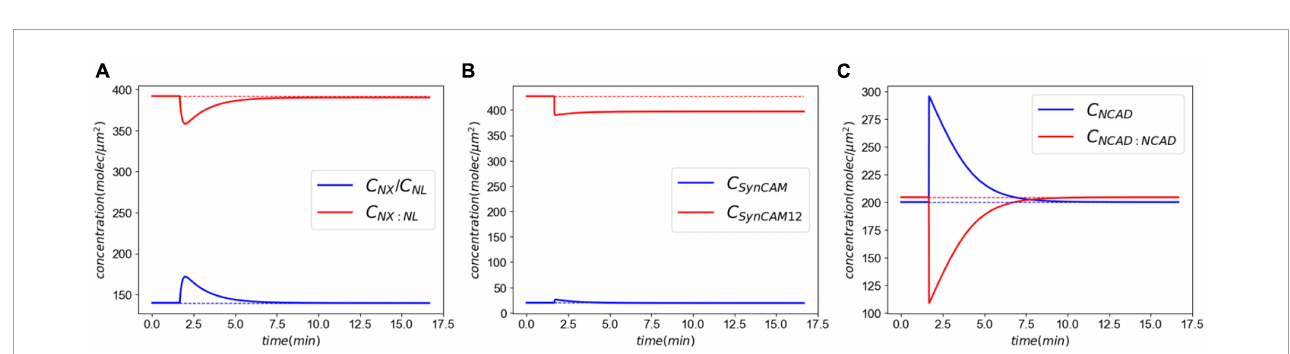
FIGURE4 Molecular response to an acute insult. Panel (A) shows the XL and its constitutive CAMs response. The initial concentrations are almost fully recovered minutes after the insult. Panel (B) shows the SynCAM response. A clear loss of SynCAM12 complexes are predicted as a result of the injury. This loss will be remedied days-months via natural degradation and synthesis of SynCAMs. Conversely, the loss of NCADs minutes after the insult panel (C) due to lack of the pulling rate dependent